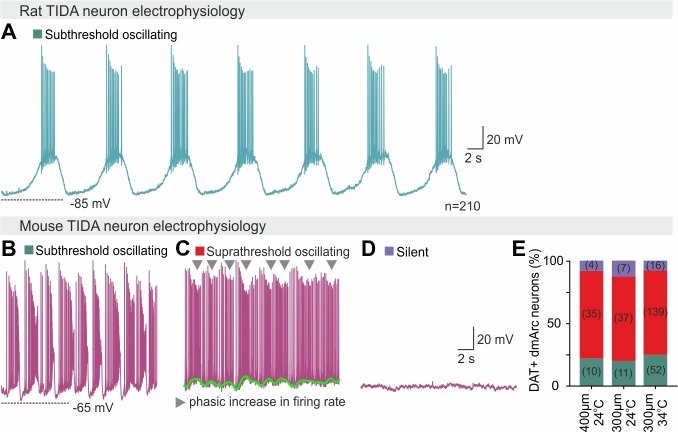
Homogeneous vs heterogeneous electrophysiological activity in rat vs mouse TIDA neurons.(A) Representative whole-cell current clamp recording of a TIDA neuron from a hypothalamic rat brain slice. (B–D) Representative whole-cell current clamp recordings of three mouse TIDA neurons, illustrate the wide spectrum of electrical activity (subthreshold oscillating, suprathreshold oscillating and silent) found in the murine TIDA population. (E) Quantification of the percentage of neurons found at the three different states shown in (b–d) under different recording conditions. Note that the proportions remain the same regardless of network volume (slice thickness, 300 or 400 μm) or temperature (24°C or 34°C).